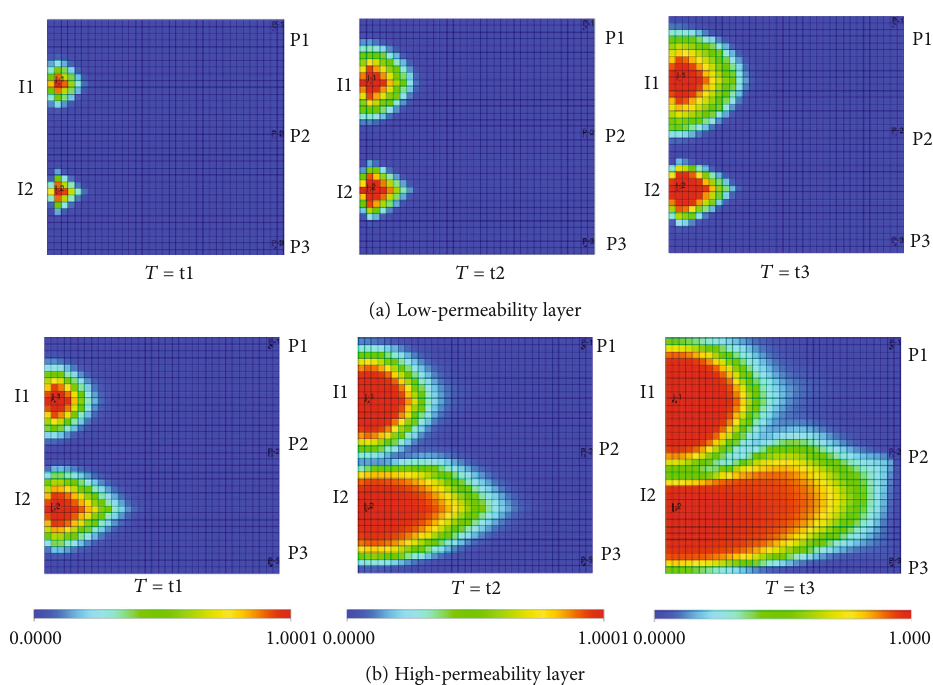
Figure 6: Distribution of injected fl uid at di ff erent time in water-polymer co fl